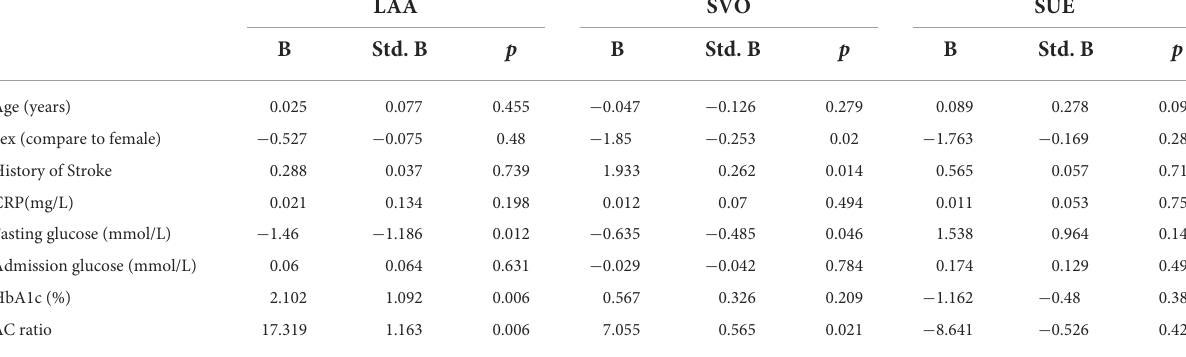
TABLE 4 Regression analysis of admission NIHSS in different etiology